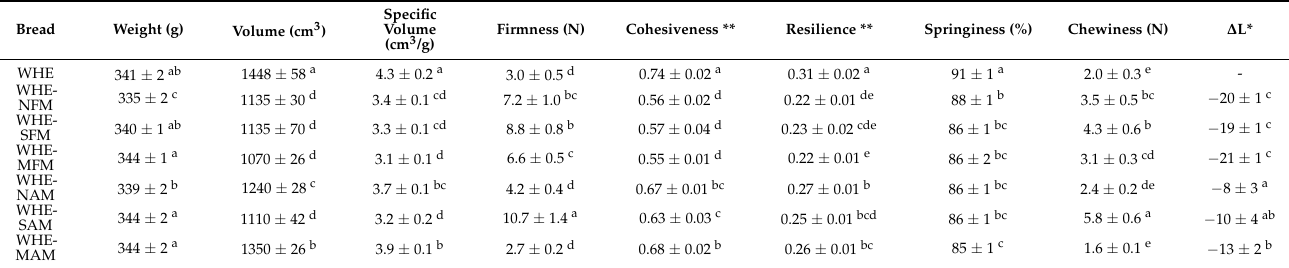
Table 4. Physical and textural properties of